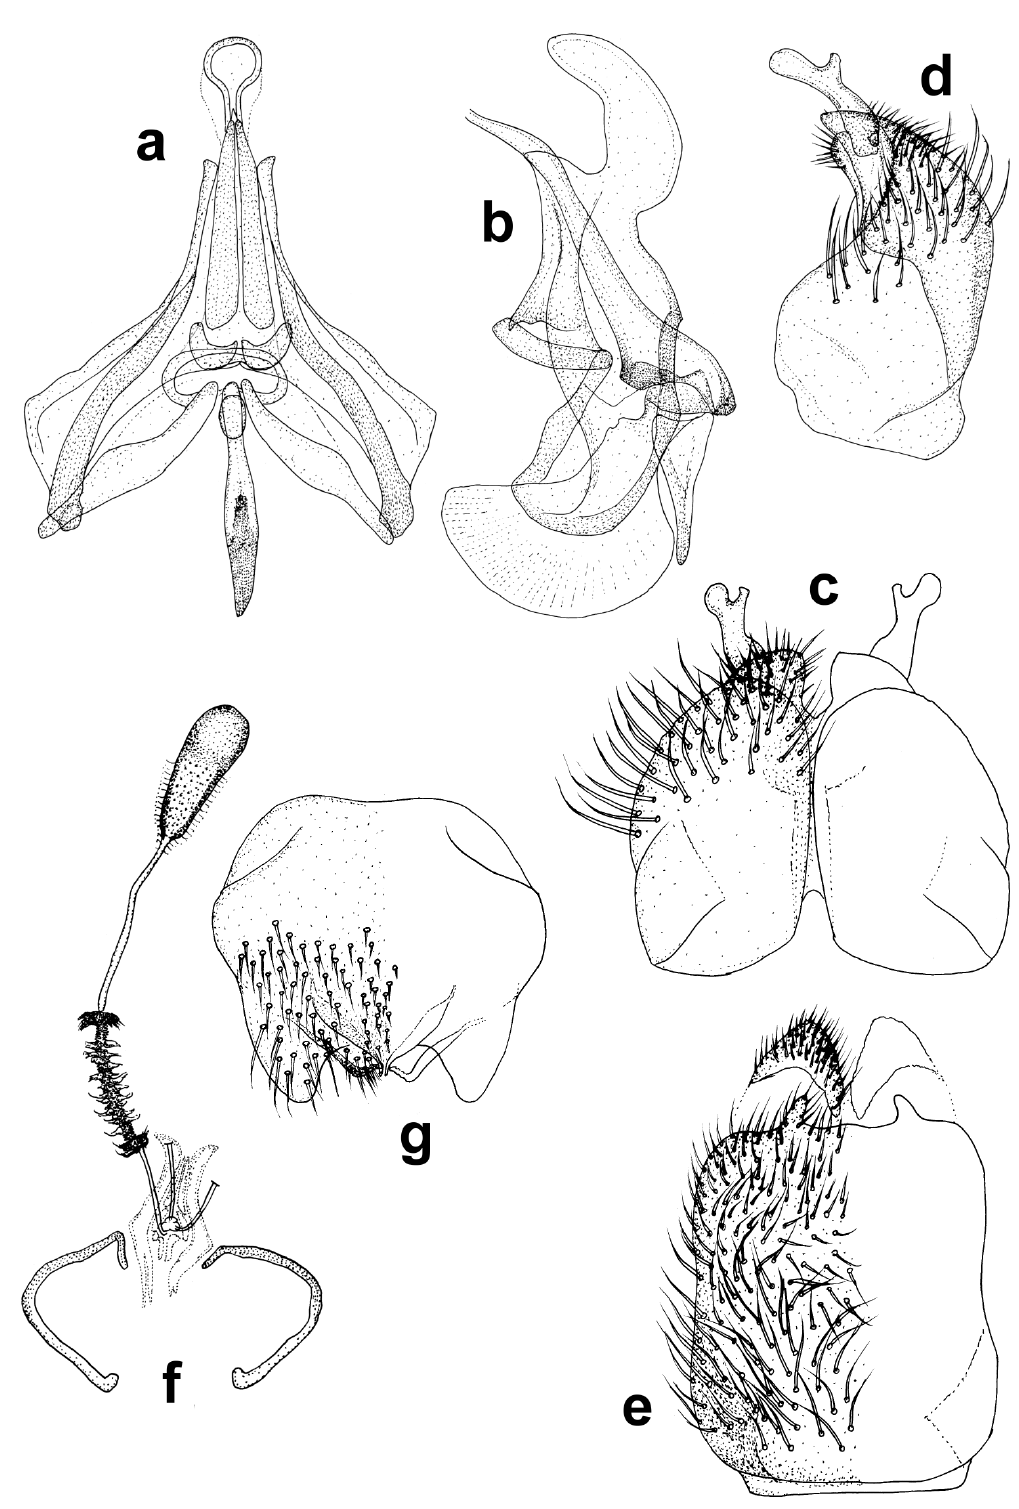
Fig. 36. Parageron lutescens (Bezzi, 1925), Nigerian specimens. a–e . Swollen proboscis form. a . Epiphallic complex ventral. b . Epiphallic complex lateral. c . Gonocoxite ventral. d . Gonocoxite lateral. e . Epandrium dorsal. f–g . Large pale yellow form. f . Female genitalia ventral. g . Female sternite 8